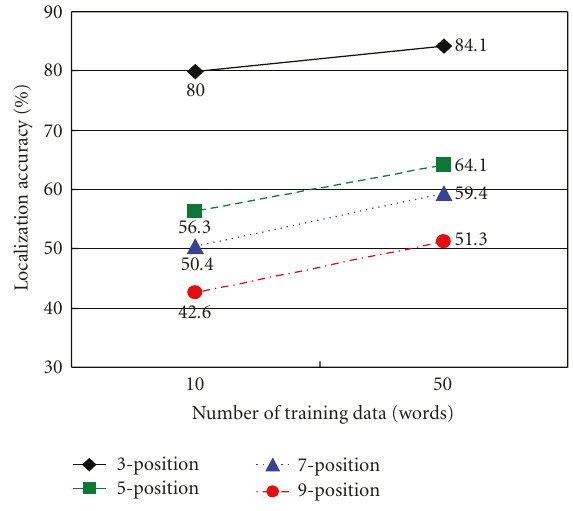
Figure 7: Comparison of the di ff erent number of training data.